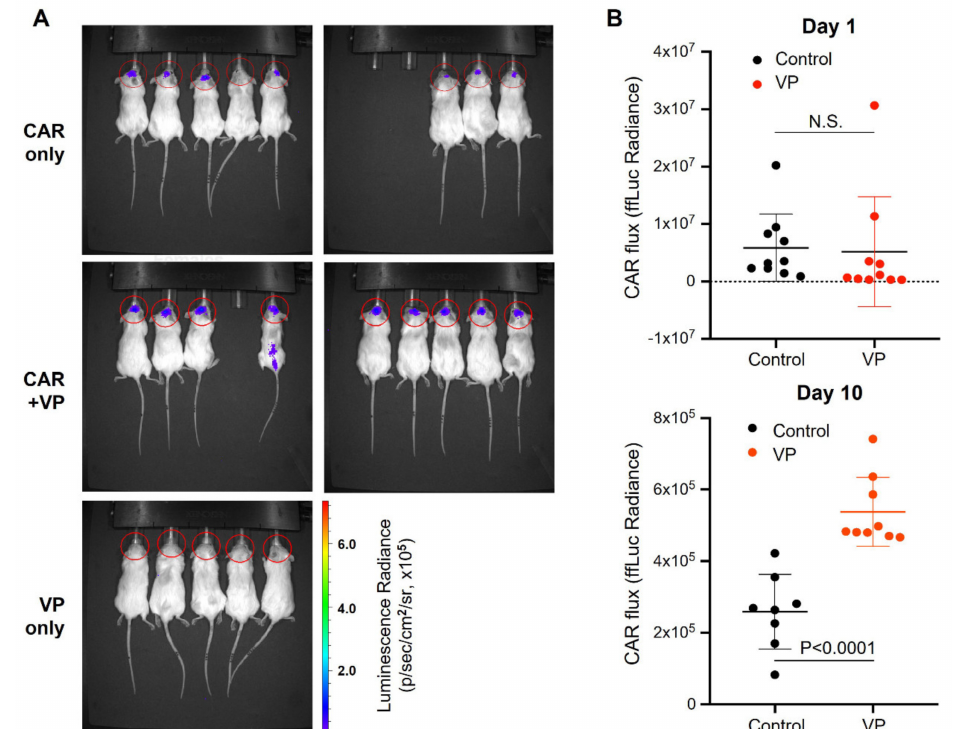
Figure 7. Verteporfin increases CAR persistence in tumors. ( A ) BLI of the CAR signals was assayed on day 10 after infusion with and without verteporfin. ( B ) Summarized data of firefly bioluminescence (ffLuc) imaging of CAR signal acquired on day 1 (infusion) and day 10 after infusion into U87- EGFRvII tumors (implanted on day 4) with and without treatment of verteporfin for 3 days prior to CAR infusion.